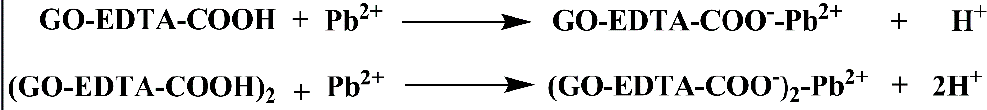
Scheme 2. Adsorption of Pb(II) ions involving complex forming of EDTA with Pb(II)